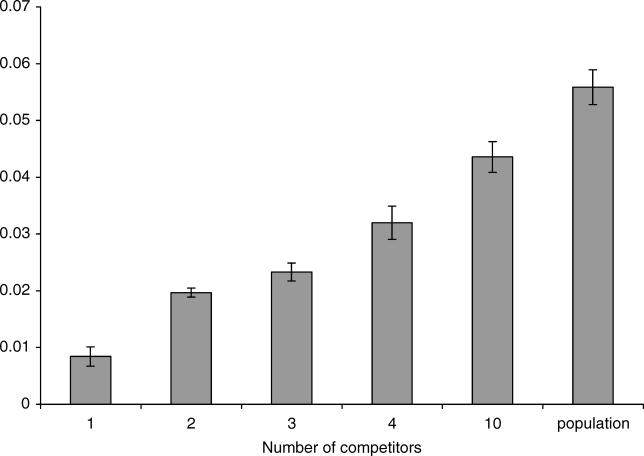
Relationship between Genetic Diversity of Competitors (Complexity) and Mean Fitness of the Clone Carrying the Beneficial Mutation (Sweeper)Fitness of the sweeper was determined by competition against a single competitor (lowest level of complexity, far left bar) increasing up to the entire population (highest level of complexity, very right bar). The number of experiments performed for each experimental group and each combination of competitors can be found in Table 1. Error bars indicate the standard deviation of the Malthusian fitness parameter determined by 100 bootstrap pseudoreplicates. The mean of the means and standard deviations of these values are plotted.